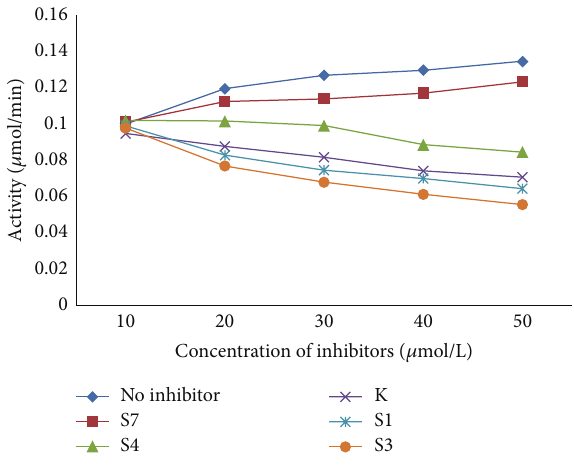
Figure 2: Effect of piperazine derivatives on AChE activity by Ellman’s